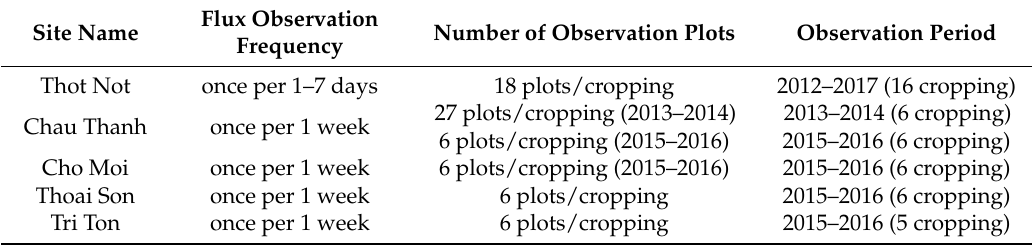
Table A1. Flux observation frequency, number of observation plots and observation period at each flux observation site.